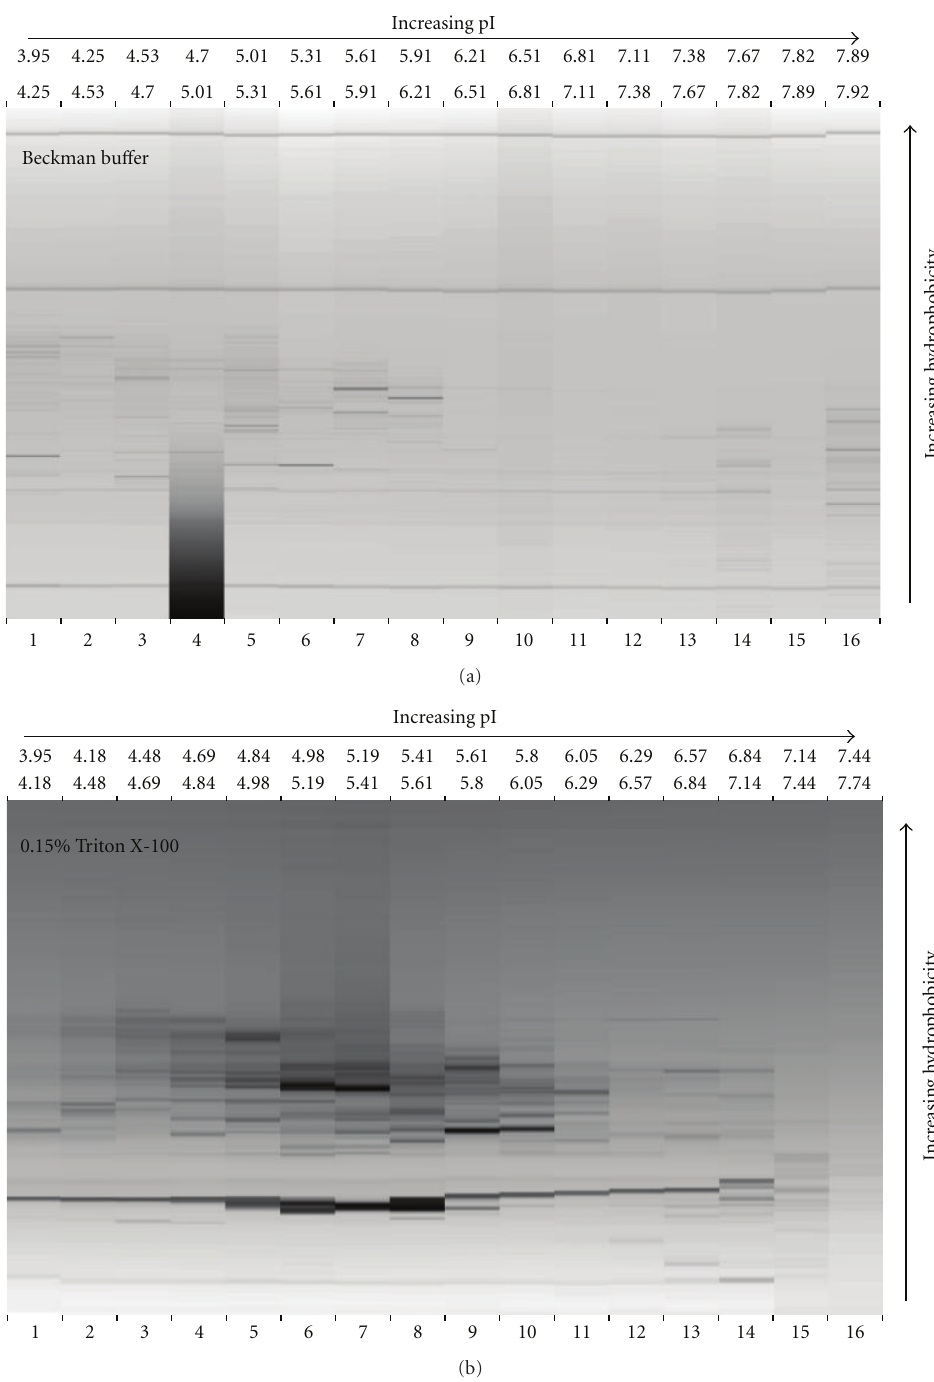
Figure 2: Second-dimension separations of 16 first-dimension fractions which were generated with Beckman Coulter bu ff er over pH 7.92– 3.95 (a) and 0.15% Triton X-100 over pH 7.74–3.95 (b). The 2D fraction profiles were monitored at 214nm and eluted in the order of increasing